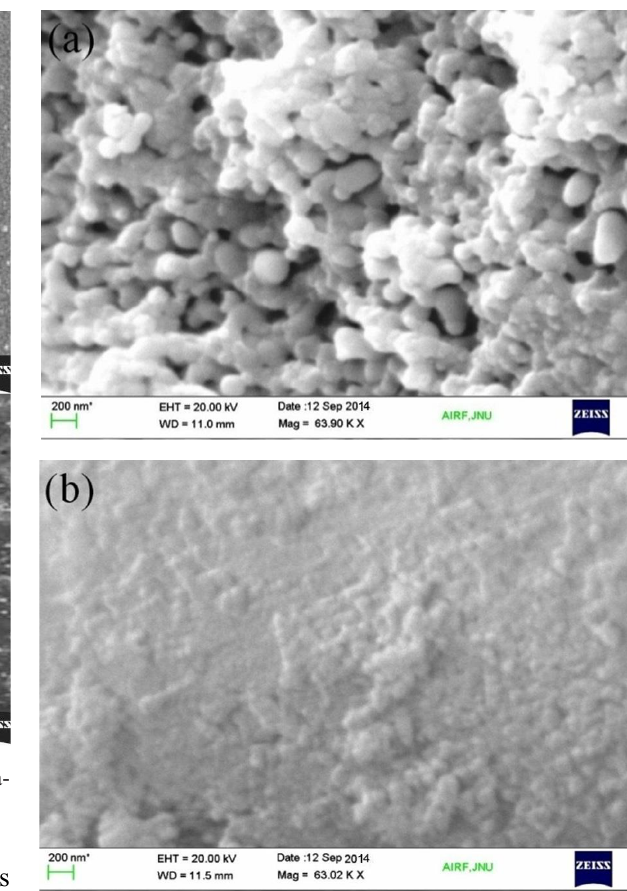
Fig. 3. SEM images of PA66/CaCO no-composites: magnification of 63.02 kx.